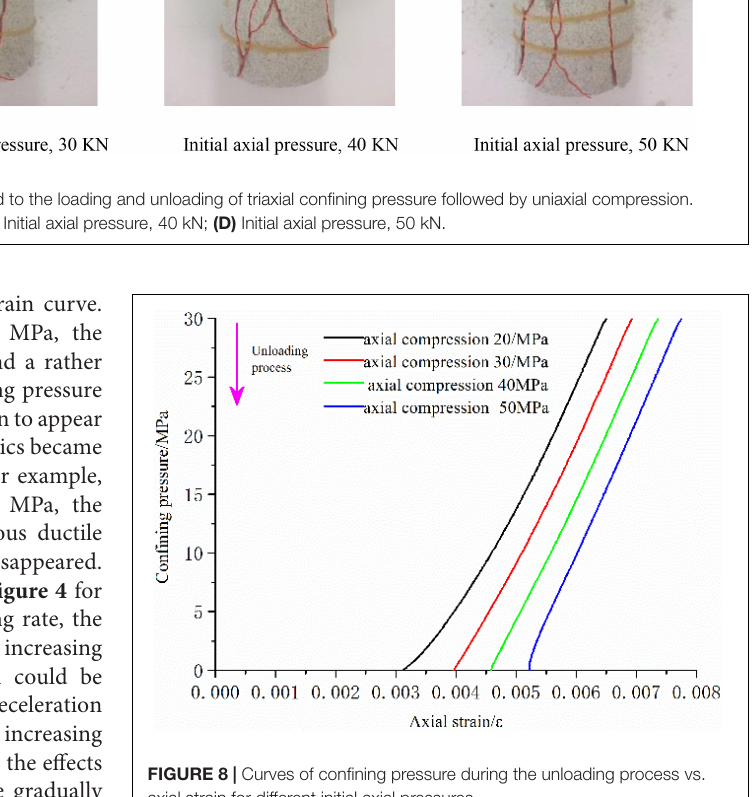
FIGURE 8 | Curves of confining pressure during the unloading process vs. axial strain for different initial axial